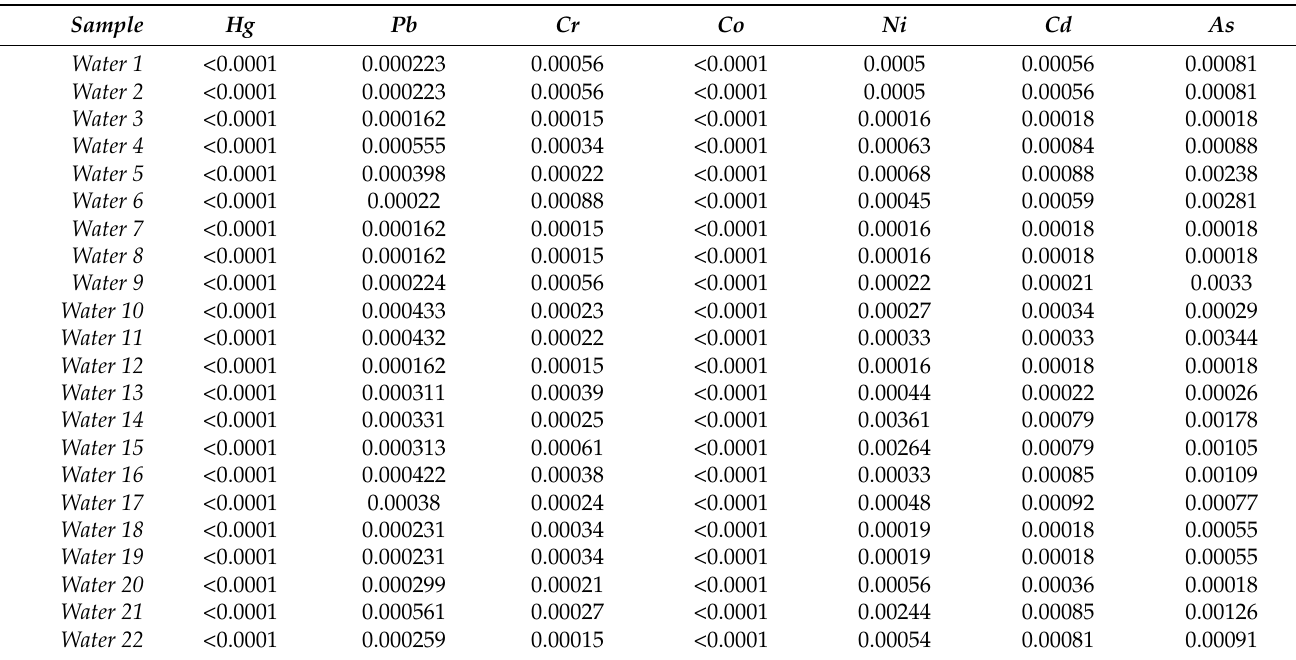
Table 5. Heavy metals analysis in forty investigated water